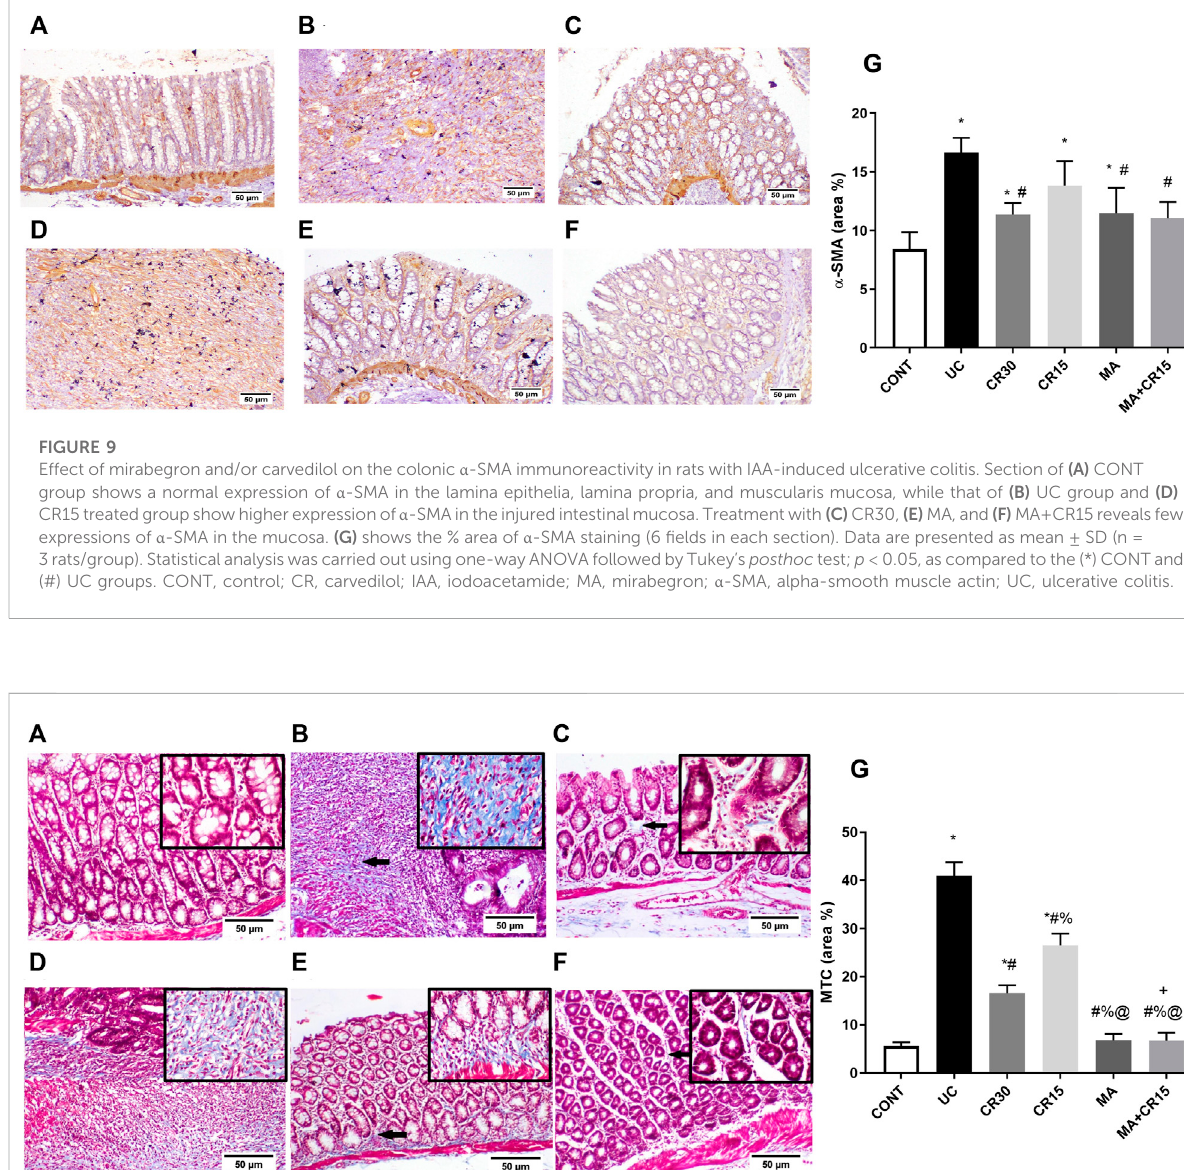
this picture was inverted in the treated groups, where all treatments decreased the protein expression of p (Y654) - β - catenin to a comparable level. Unexpectedly, carvedilol at its two doses failed to affect E-cadherin, while mirabegron alone or